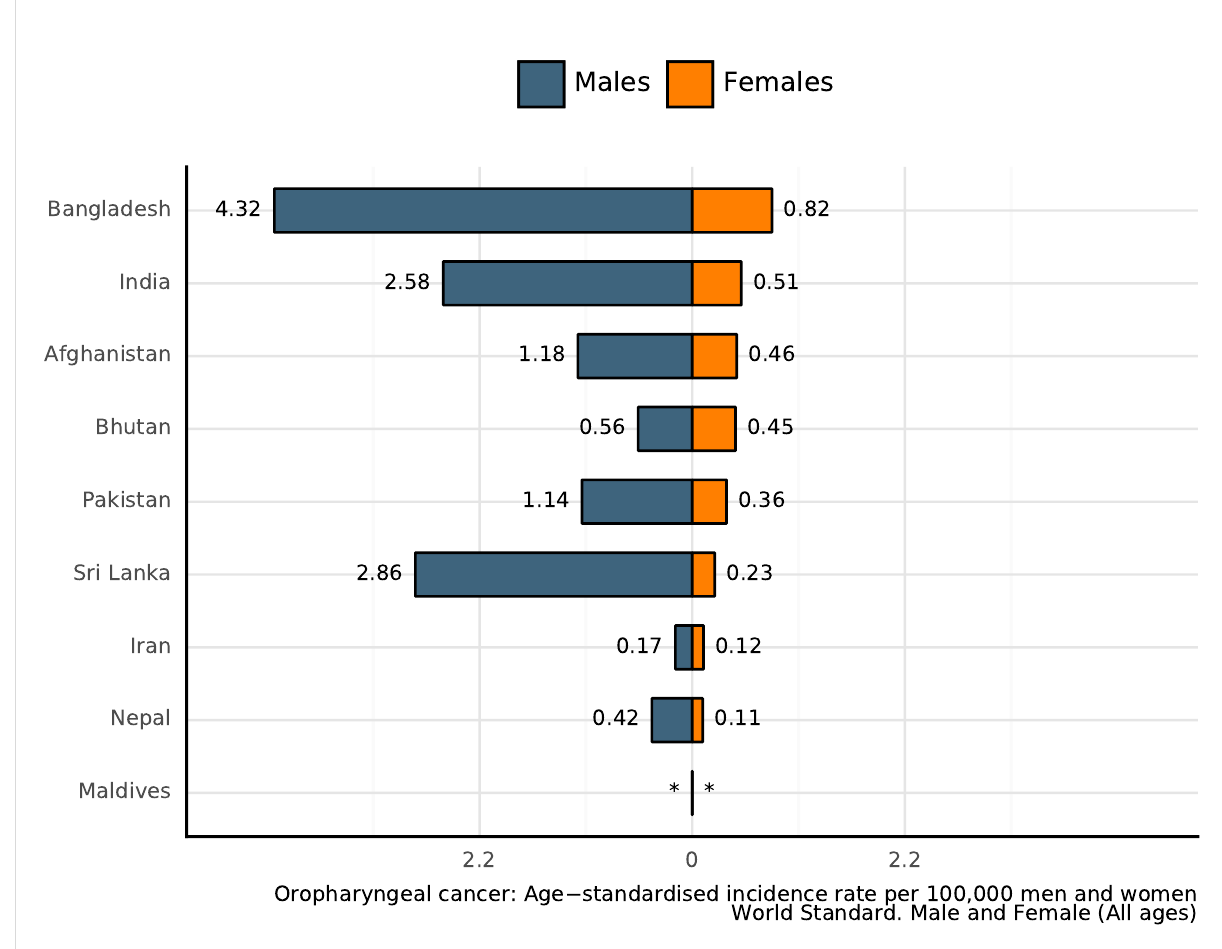
Figure 90: Age-standardised incidence rates of oropharyngeal cancer of India (estimates for 2020)